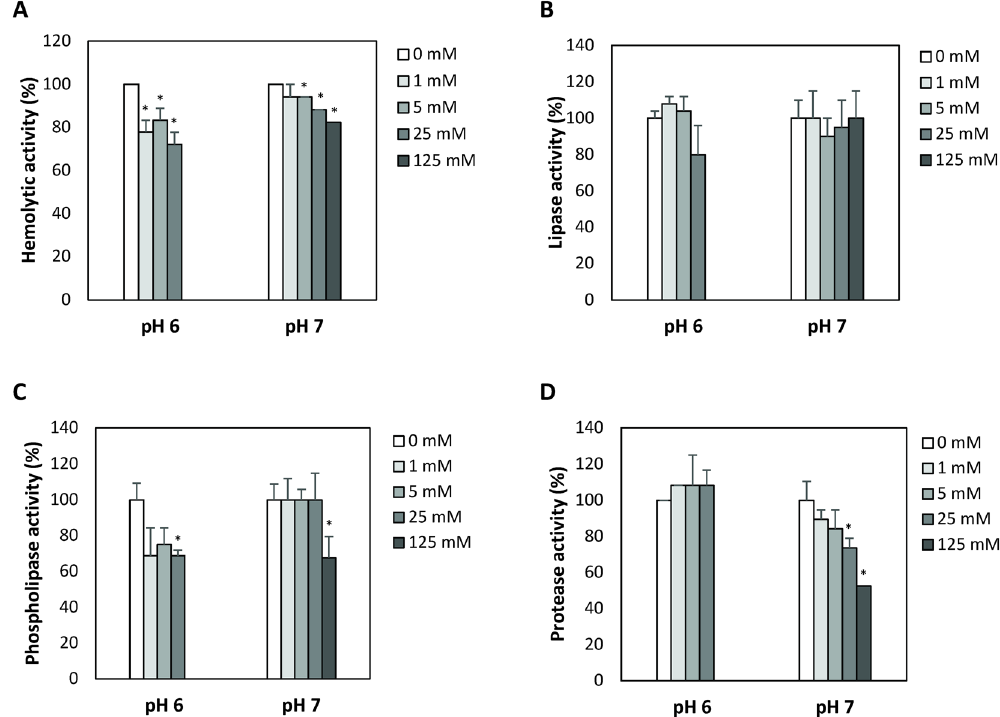
Figure 3. Hemolytic (panel A), lipase (panel B), phospholipase (panel C) and protease (panel D) activities of Vibrio campbellii ATCC BAA-1116 in the presence of different concentrations of 3-hydroxybutyrate (0, 1, 5, 25 and 125 mM, respectively), at pH 6 and 7. The activities without 3-hydroxybutyrate were set at 100% and all other treatments were normalized accordingly. Error bars represent the standard deviation of three replicates. Asterisks indicate significant differences with the treatment without 3-hydroxybuturate (P < 0.05). Treatment with 125 mM 3-hydroxybutyrate was not tested at pH